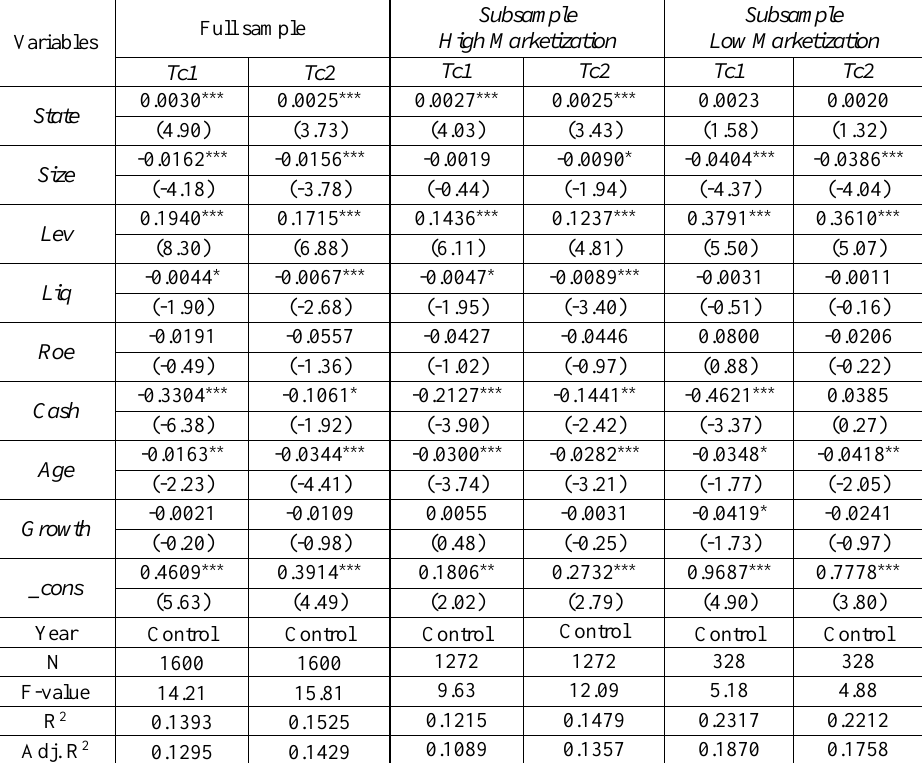
Table 1. The regression results of full sample and sub-samples a